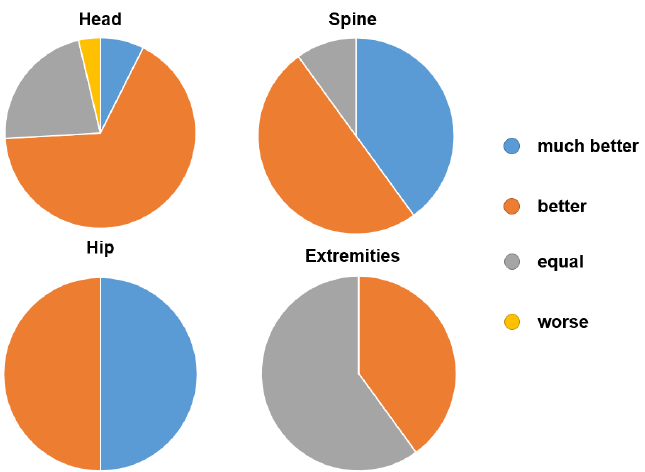
Figure 4. Breakdown of the overall examination score comparing 0.55T and 1.5T scanners, divided among the four different body regions. Table 3. Results of the patient evaluation with regard to noise, comfort, space perception, coil comfort and the overall experience (mean ± standard deviation) depending on the examined body region.